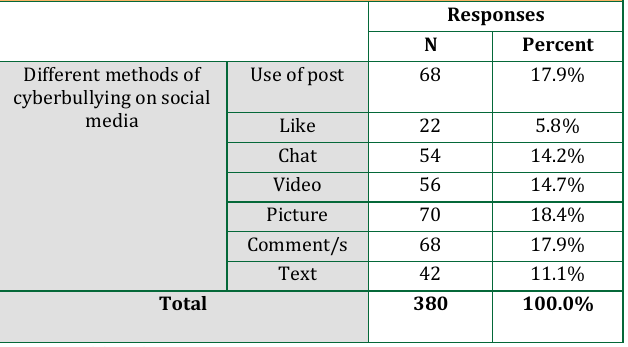
Table 3: Different methods of cyberbullying on social media Table 6: Different psychosocial factors that motivate cyberbullying on